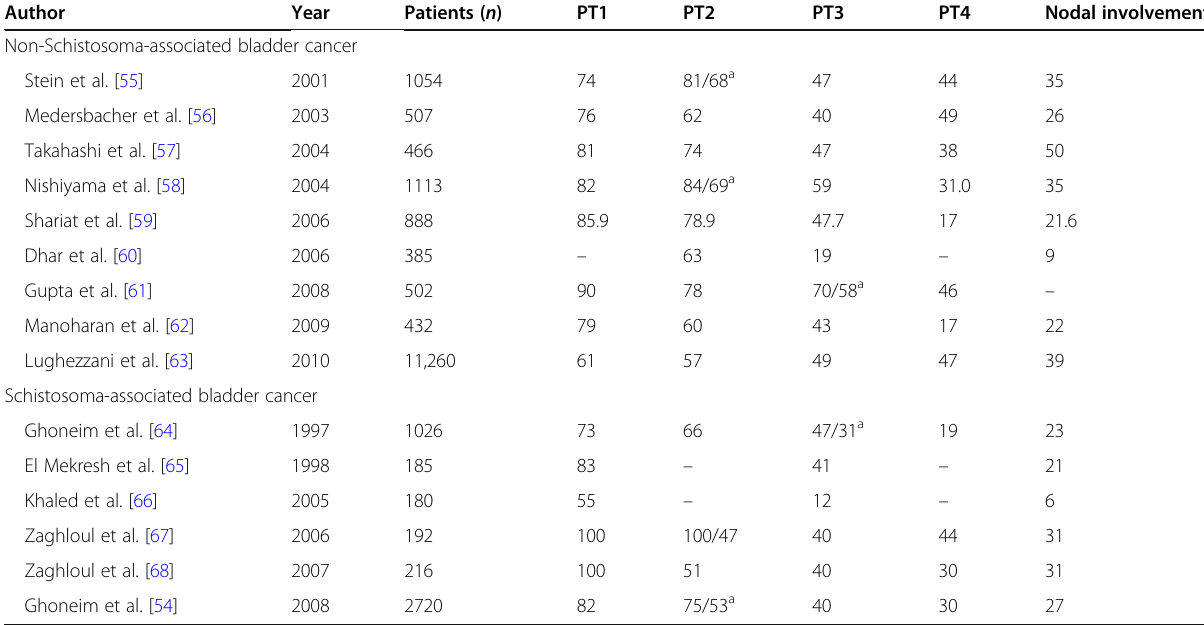
Table 1 The 5-year overall survival rates by pathological stage in non-Schistosoma-associated bladder cancer (SNA-BC) and Schistosoma-associated bladder cancer